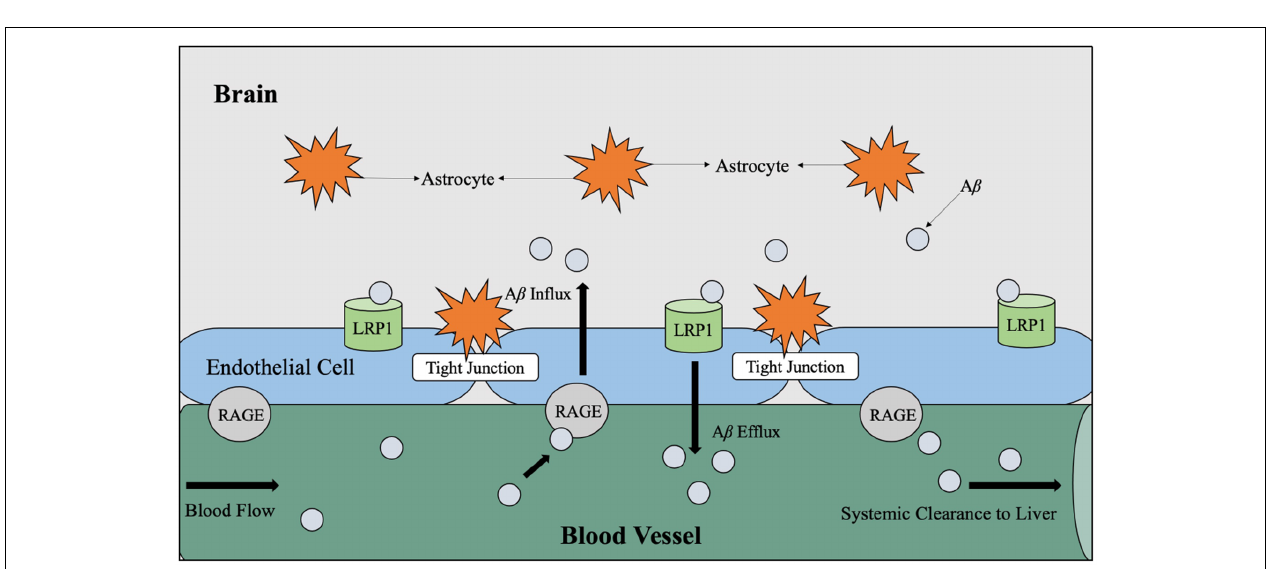
FIGURE 4 | A β dysfunction contributing to alterations in brain insulin signaling beginning with the activation of TNF α and NMDAR by A β . During A β accumulation found in AD brains, there is increased expression of TNF α and activation of NMDAR. NMDAR activation results in an influx of Ca 2+ that leads to oxidative stress and synaptic dysfunction of the brain. Under normal conditions, A β is used to regulate the calcium flow that is required for synaptic transmission. Increased expression of TNF α and stress kinases leads to inhibitory serine phosphorylation of IRS-1 and PI3K therefore reduced glucose uptake. The effects of A β accumulation and toxic stress triggers a cascade of impaired insulin signaling. Abbreviations: A β , amyloid beta; TNF α , tumor necrosis factor α ; NMDAR, N-Methyl-D aspartate receptor; IRS-1, insulin receptor substrate-1; PI3k, phosphatidylinositol-3-kinase; AKT, protein kinase B; pTau, hyperphosphorylated tau; GLUT4, glucose transporter 4; JNK, N-terminal kinases; PKR, protein kinase R; Ikr, rapid-component delayed-rectifier potassium channel.